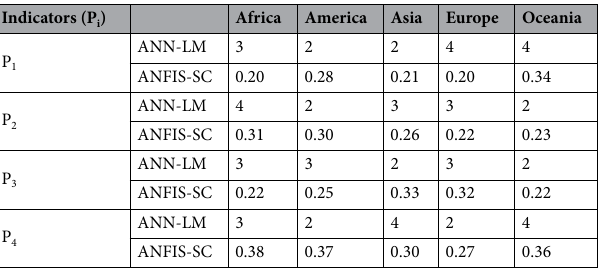
Table 4. The characteristics of ANN (the number of neurons) and ANFIS (radii values) models corresponding to social indicators and